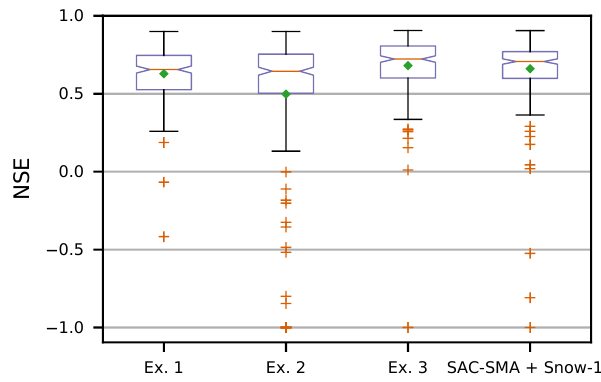
Figure 14. Boxplot of the NSE of the validation period for our three Experiments and the benchmark model. The NSE is capped to − 1 for better visualization. The green square diamond marks the mean in addition to the median (red line).